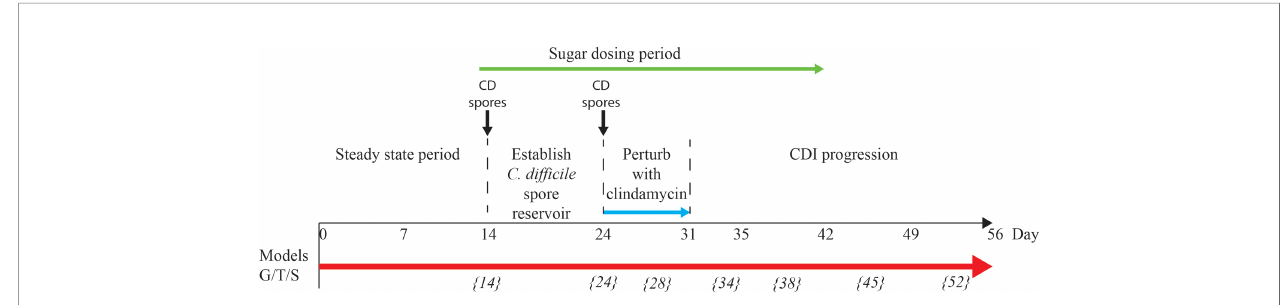
FIGURE 1 | Schematic timeline of the in vitro triple vessel chemostat gut model and experimental design for each model. C. dif fi cile spores (black lines) were instilled and commencement of sugar regimen [either trehalose (T), glucose (G) or saline (S) (green arrow)] before addition of antibiotics (blue arrow). Microbial populations were monitored post antibiotic for recovery and induction of CDI. Numbers in italicise brackets denotes the day that samples for DNA extraction were